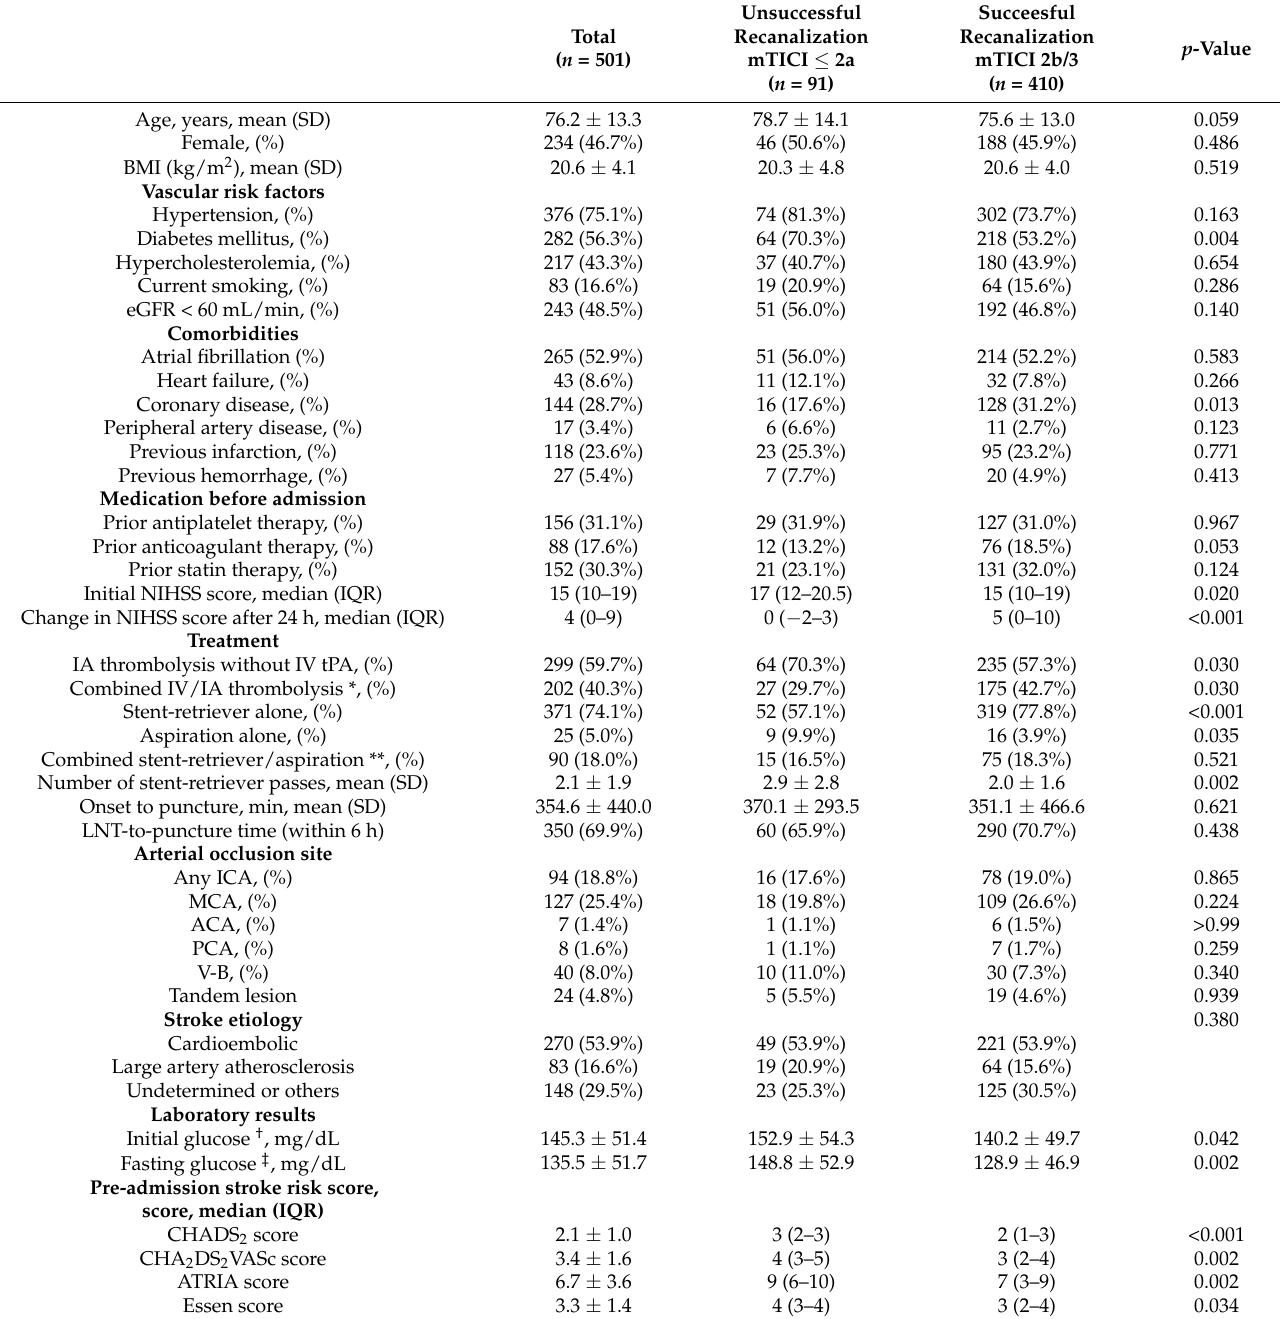
Table 1. Clinical and imaging characteristics according to the degree of